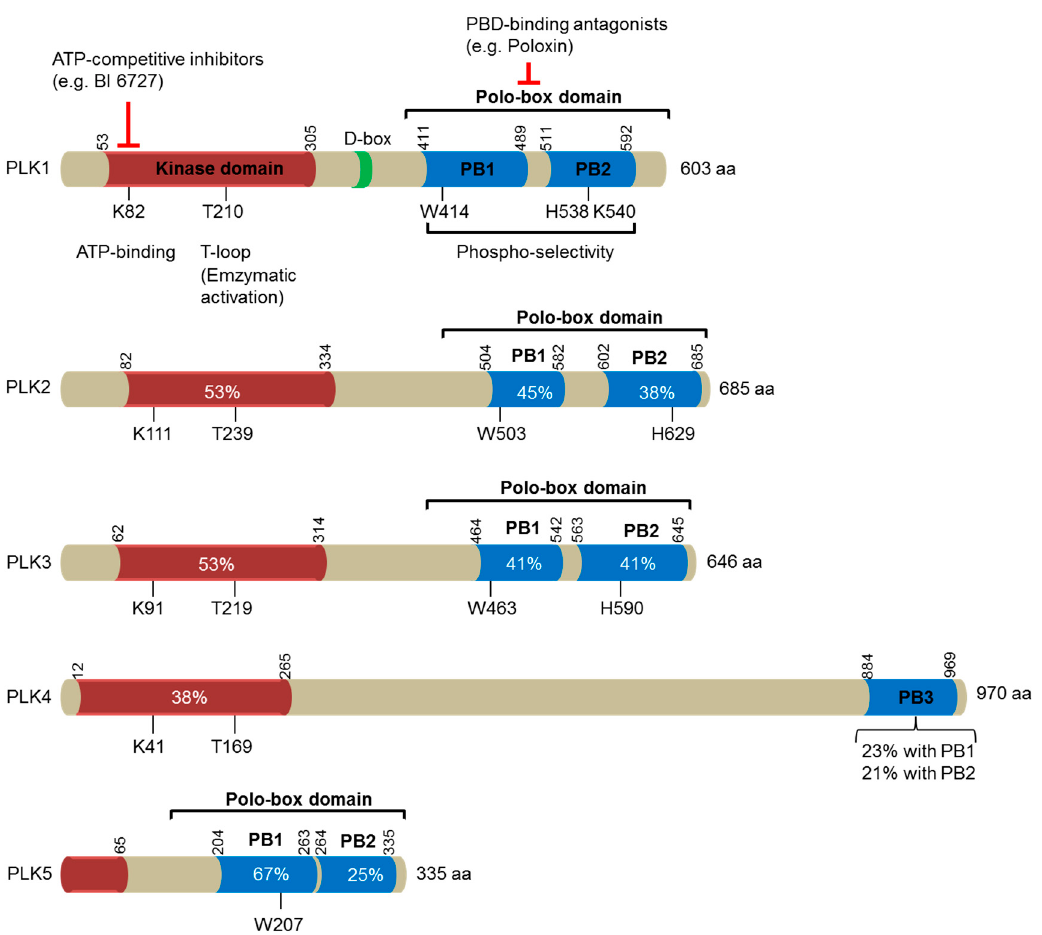
Figure 1. A schematic diagram illustrating the domain structures of the human polo-like kinase (PLK) family of proteins (PLK1-5). The number of amino acids in each family member is indicated on the right. The location of the kinase domains is shown in orange, whereas the polo-box domains (PBD), made of two polo-boxes (PB), are represented in blue. These two domains are separated by the interdomain linker, which comprises a destruction box (D-Box) indicated in green. The numbers indicate the first and the last residues of these domains in human PLKs. Residues that are essential for ATP-binding and enzymatic activation (T-loop) within the kinase domains, and for phosphoselectivity within the polo-box domains, are depicted. Sequence identities with the corresponding domains in PLK1 are provided in percentages. Two distinct strategies for targeting PLK1 are included: ATP-competitive inhibitors targeting the catalytic activity of PLK1, and PBD-binding antagonists competitively inhibiting the function of PBD.